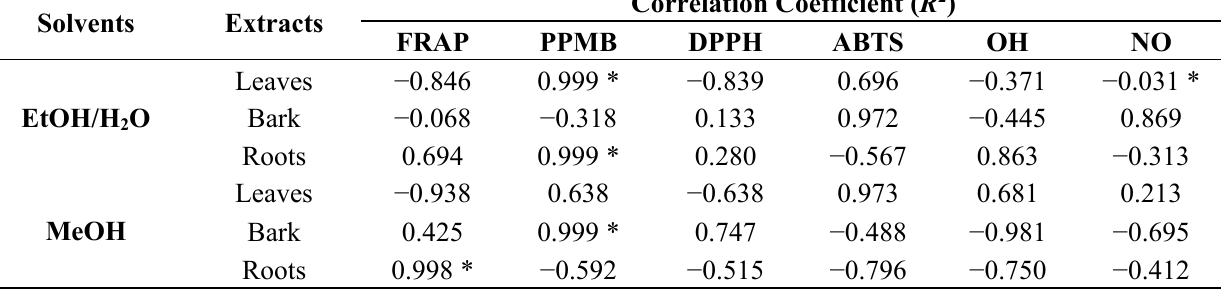
Table 5. Pearson correlation analysis between polyphenol content and antioxidant properties.